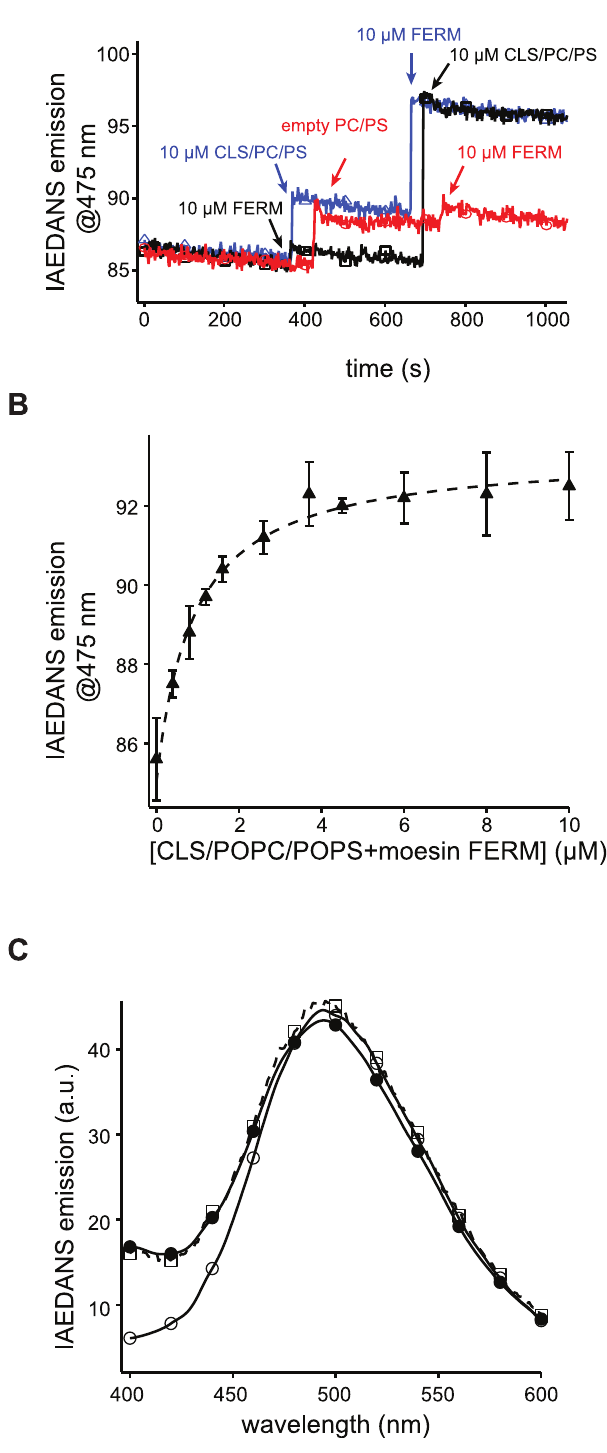
Figure 5. CaM adopts an extended conformation in its ternary complex with CLS and moesin FERM domain. A, time-based IAEDANS emission traces of 125 nM I-CaM in 10 mM MOPS, 100 mM NaCl, 0.3 mM CaCl 2 , pH 7.4. 10 m M (final concentration) moesin FERM domain or 10 m M (final concentration) CLS/POPC/POPS (1/850/150 molar ratio) or empty POPC/POPS liposome was added to the I-CaM solution at indicated time points. Differently colored traces indicate separate runs. The excitation and emission wavelengths were set to 340 and 475 nm, respectively. B, The titration plot of I-CaM by the complex of CLS/POPC/POPS and moesin FERM domain. The mixture of CLS/POPC/POPS and moesin FERM, at 1:1 molar ratio, was titrated to the I-CaM solution at indicated concentrations, and the IAEDANS emission at 475 nm was measured. The background scattering fluorescence as a result of added liposome was subtracted from each measurement. Dashed line indicates the fitted binding curve. C, IAEDANS